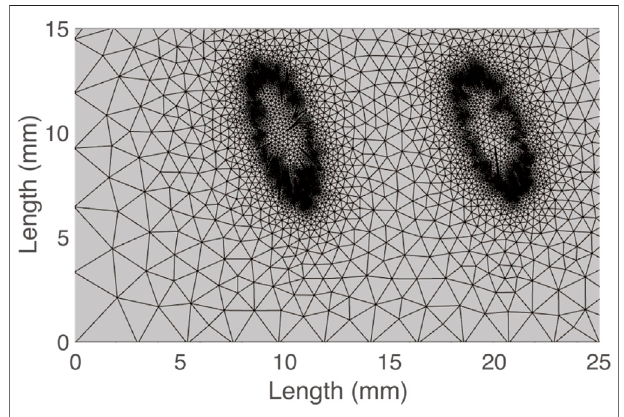
FIGURE 3 | The mesh around the